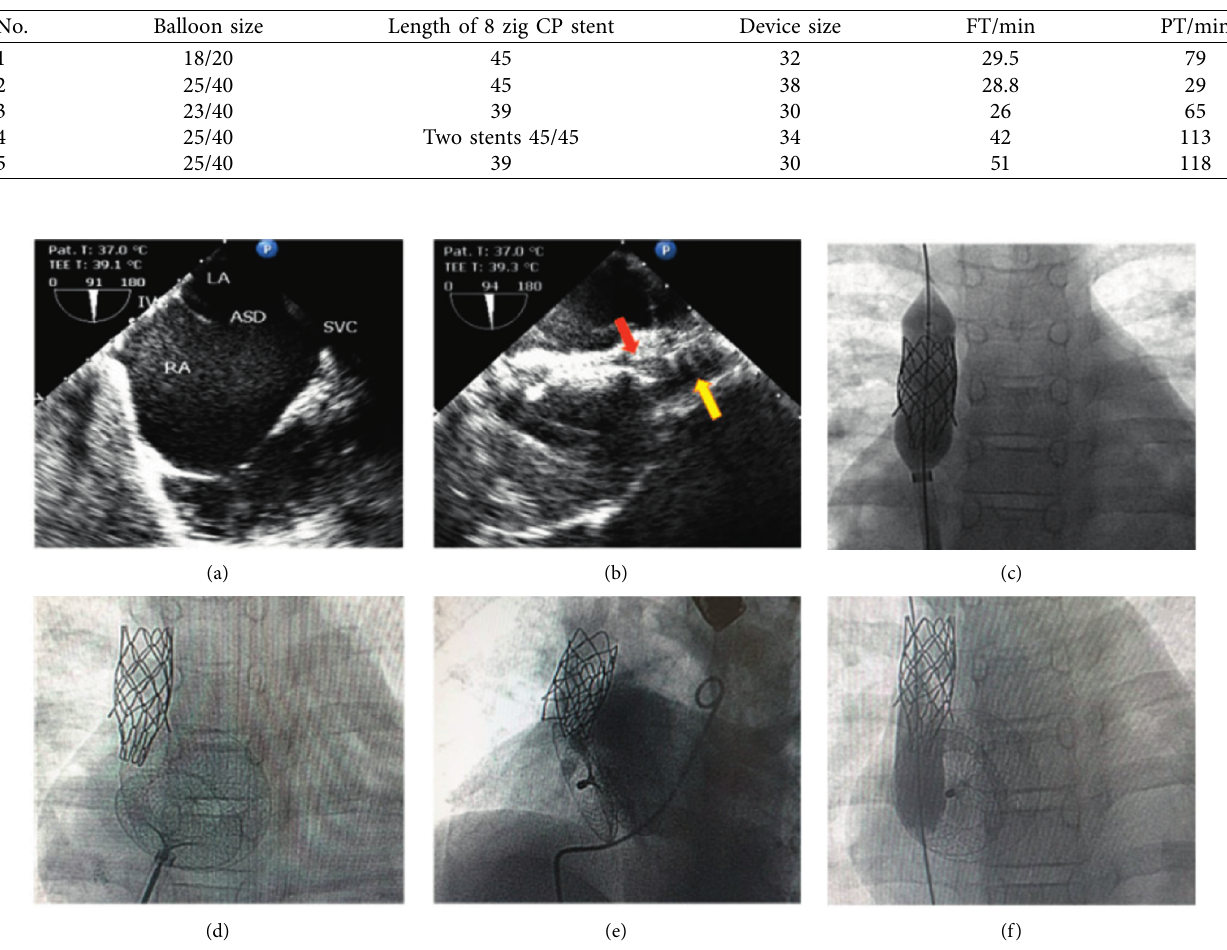
Figure 1: (a) Two-dimensional transesophageal echocardiography (TEE) imaging in long-axis bicaval view demonstrates a large secundum ASD with an absent rim near the SVC. (b) TEE in long axis view reveals the struts of the CP stent (yellow arrow) with the atrial septal occluder (red arrow) anchoring on the newly created superior rim by tight inflation of the covered-CP stent. (c) Cine imaging of the heart in the frontal projection demonstrates the inflation of the modified covered CP-stent 8 zig, 45mm length by Z-med balloon size 22 × 40mm. (d) Cine imaging of the heart in the frontal projection shows the deployed ASO in proper position with the projected part of the modified CP-stent out of RA disc before release. (e) Selective PA angiogram in four chamber view (LAO 35, cranial 35) demonstrates complete closure of the defect with no residual shunt. (f) Cine imaging of the heart in frontal projection demonstrates the inflated Z-med balloon (25 × 40 mm) slipped down in front of the septal occluder which did not capture the projected part of the modified CP stent, this balloon dilatation have been done three years later to achieve adult size of